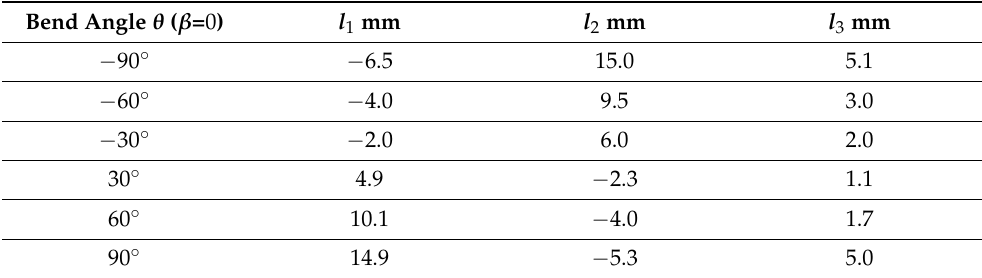
Table 1. Measured wire length changes at shown angular positions [38].